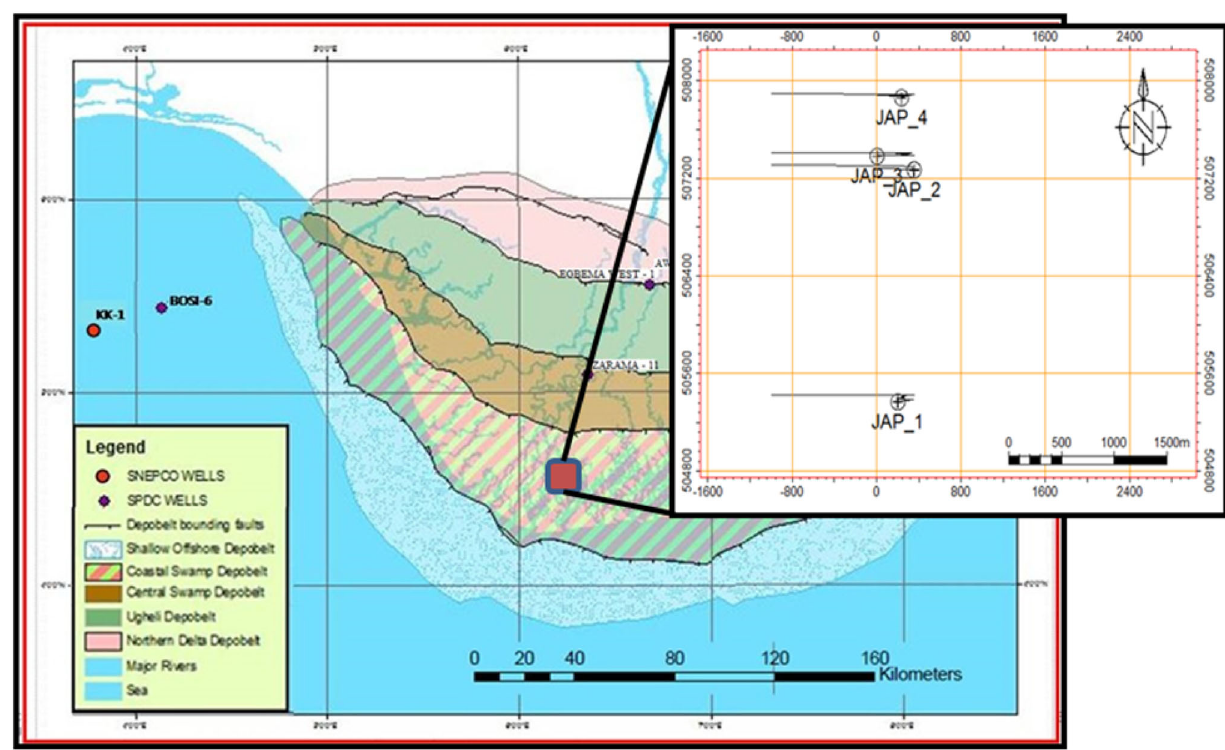
Fig. 1 Map of the Niger Delta depobelts, showing the location of ‘‘Akbar Field’’ (Modified from Okosun and Osterloff